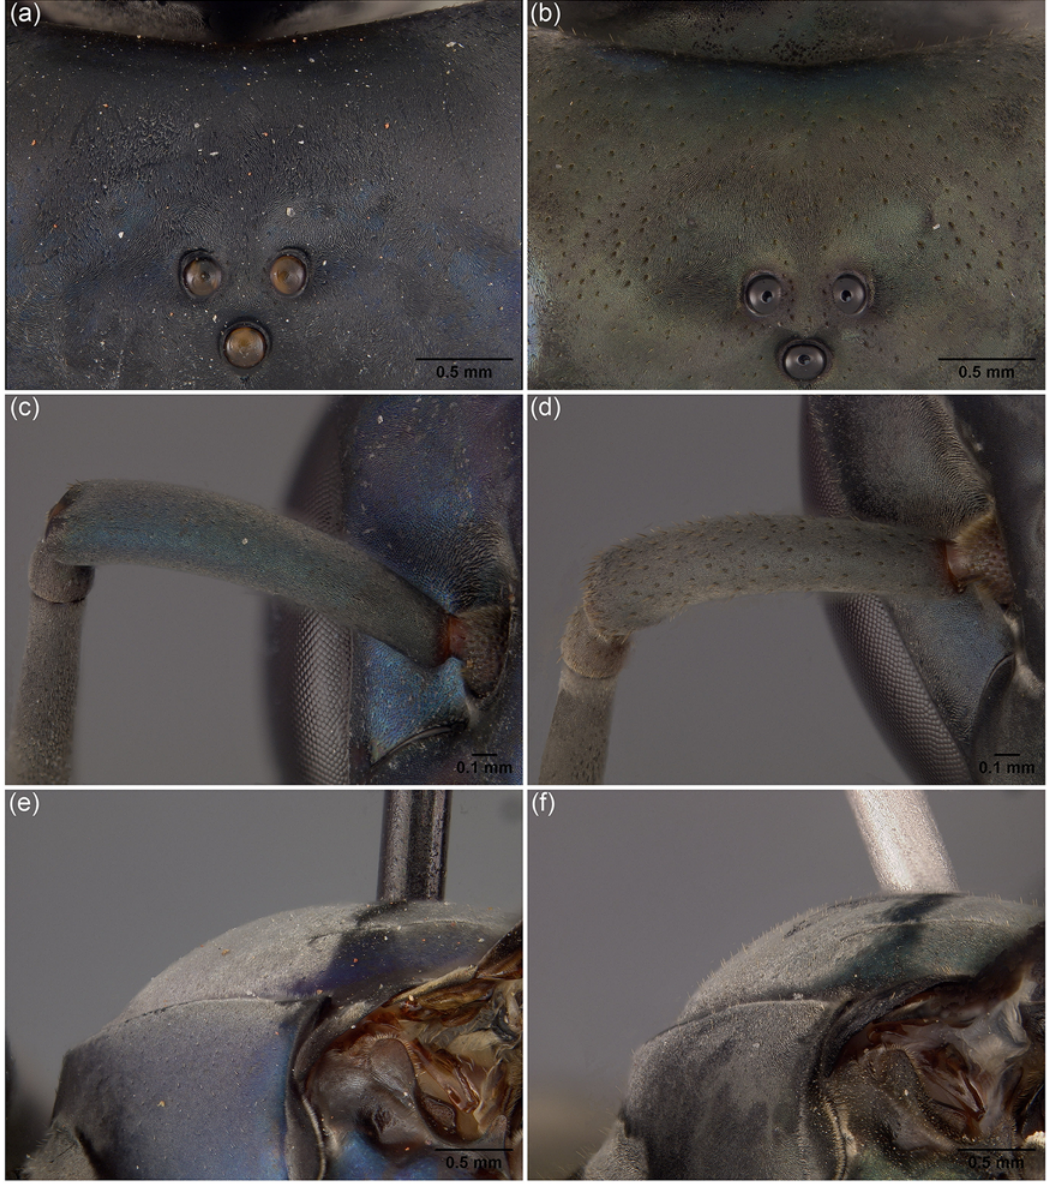
Fig 2. External morphological structures observed. View frontal of head, (a) S . surinama and (b) S . septentrionalis . View frontal of scape, (c) S . cyanea and (d) S . septentrionalis . Scutum in lateral view, (e) S . surinama and (f) S . septentrionalis